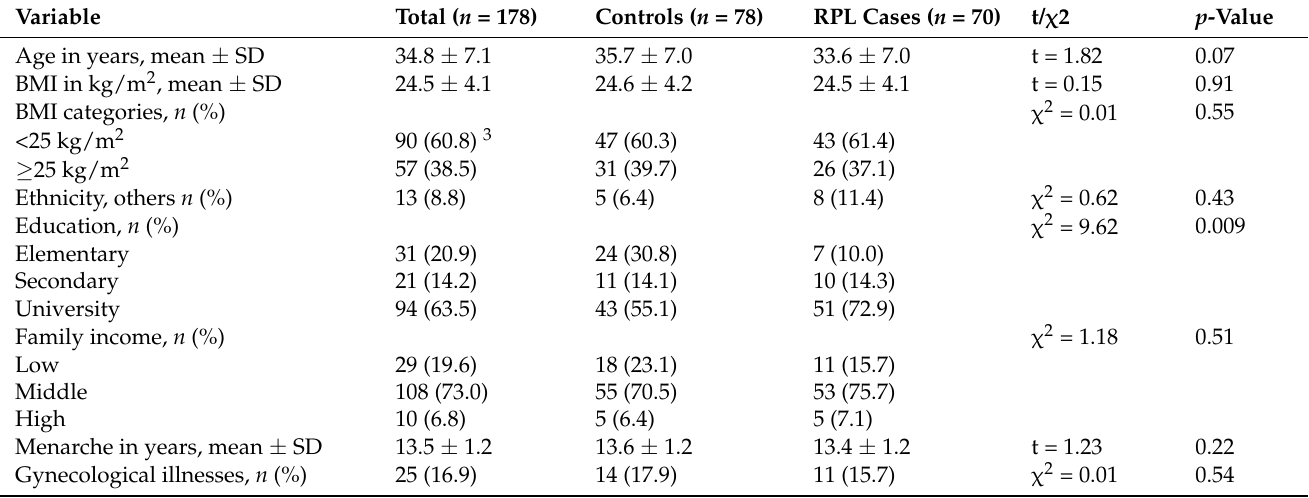
Table 1. Socio-demographic, reproductive characteristics and medical history of the study participants attended the National Research Center for Mother and Child Health, Astana,